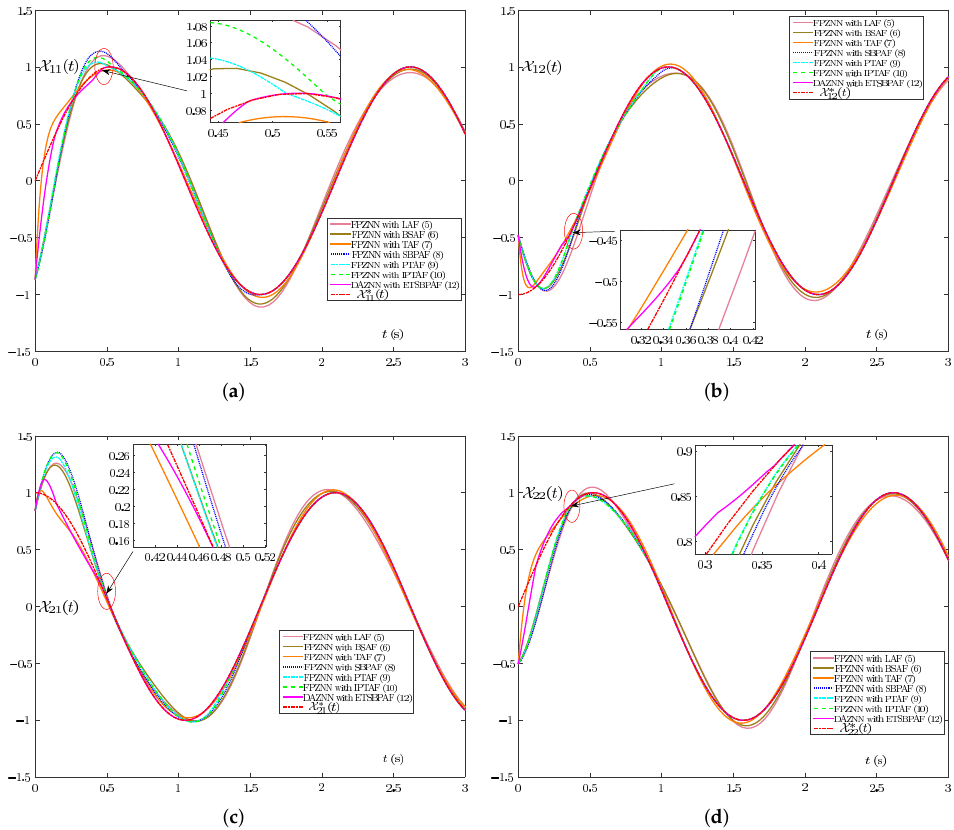
Figure 1. Trajectories of the solutions X ( t ) of different models, of which the red line denotes the theoretical solution X ∗ ( b ) Theoretical solution X ∗